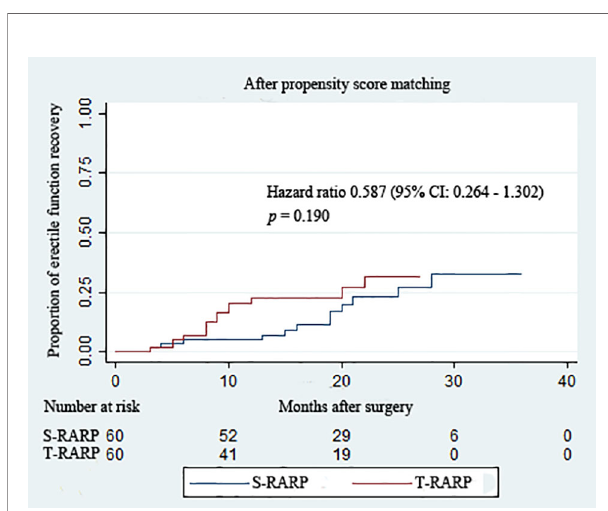
FIGURE 3 | Kaplan – Meier curves showing the proportion of postoperative erectile function recovery according to surgical type during the follow-up intervals. Erectile function recovery was de fi ned as a IIEF score ≥